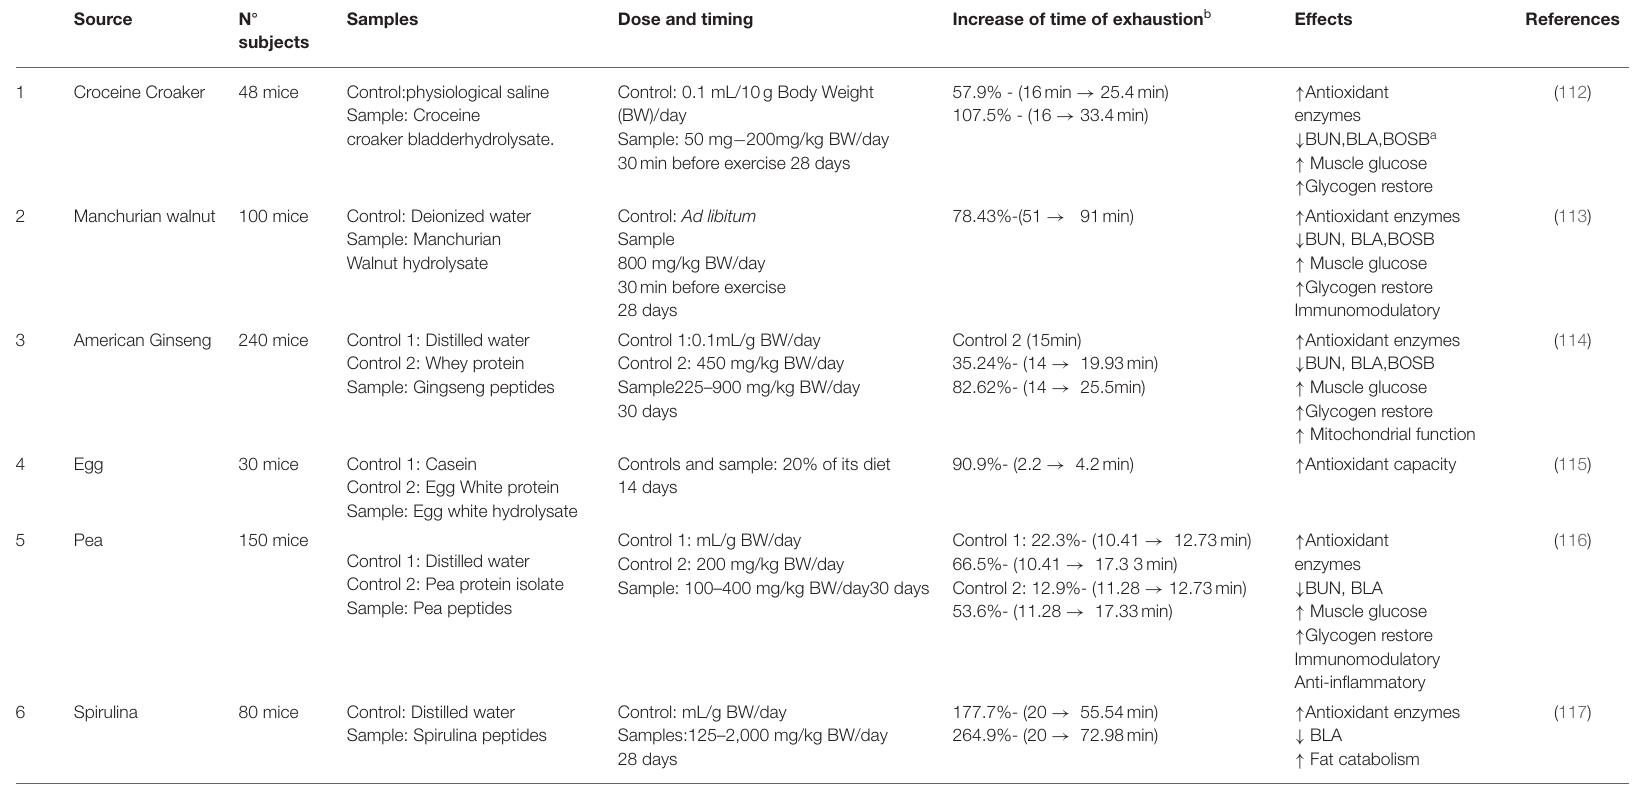
TABLE 2 | Summary of anti-fatigue peptides studies in rodent’s model.